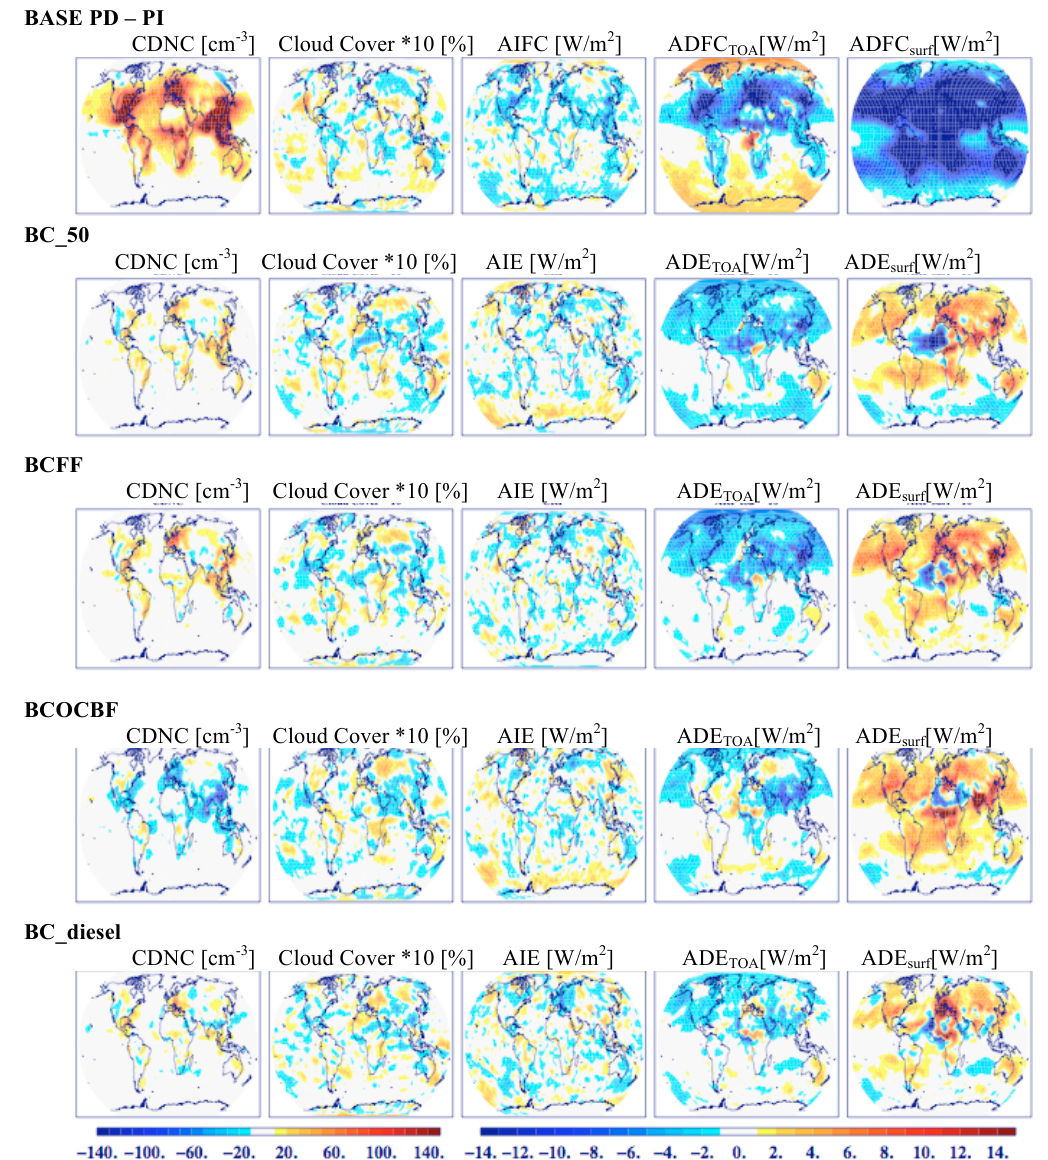
Fig. 8. Differences in CDNC [cm − 3 ], total cloud cover [%], top of the atmosphere cloud (AIE), aerosol (ADE) and surface aerosol radiative Figure 8 Differences in CDNC [cm -3 ], total cloud cover [%], top of the atmosphere cloud (AIE), flux changes [W/m 2 ], between the PD and PI in the BASE case (first panel) and the difference between BASE and the four BC reduction aerosol (ADE) and surface aerosol radiative flux changes [W/m 2 ], between the PD and PI in the BASE cases. Cloud cover and ADE are multiplied by a factor of 10 to fit the color case (first panel) and the difference between BASE and the four BC reduction cases. Cloud cover and ADE are multiplied by a factor of 10 to fit the color scheme.